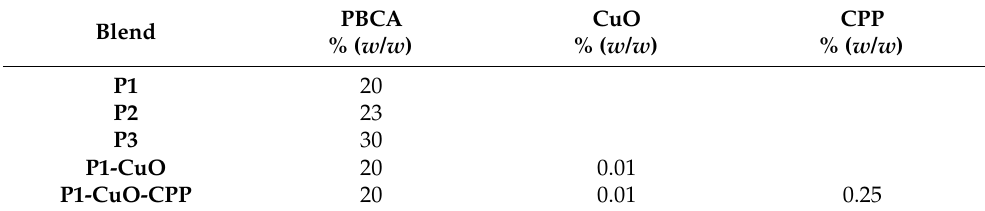
Table 2. Qualitative–quantitative composition of the polymeric